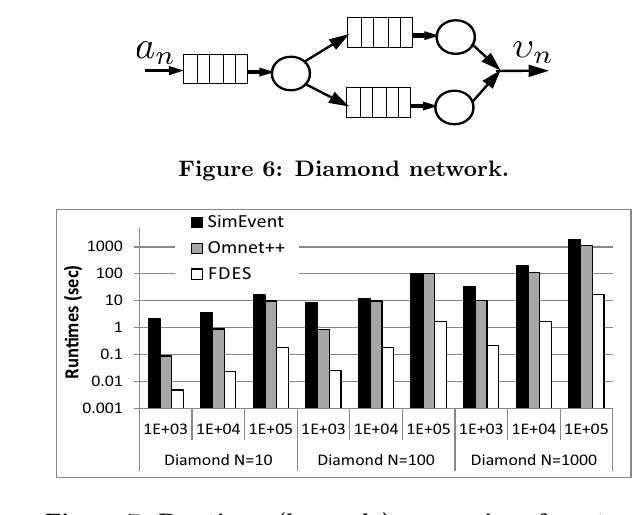
Figure 7: Runtimes (log scale) comparison for a tan- dem of diamond networks at different